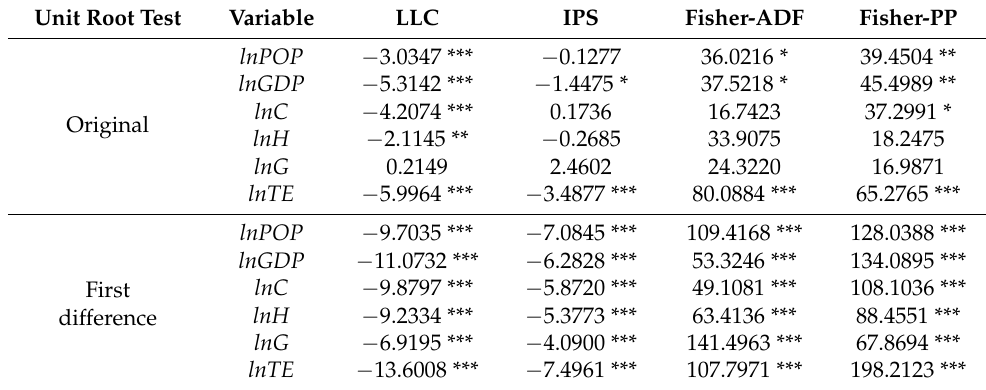
Table 3. Unit root test results of